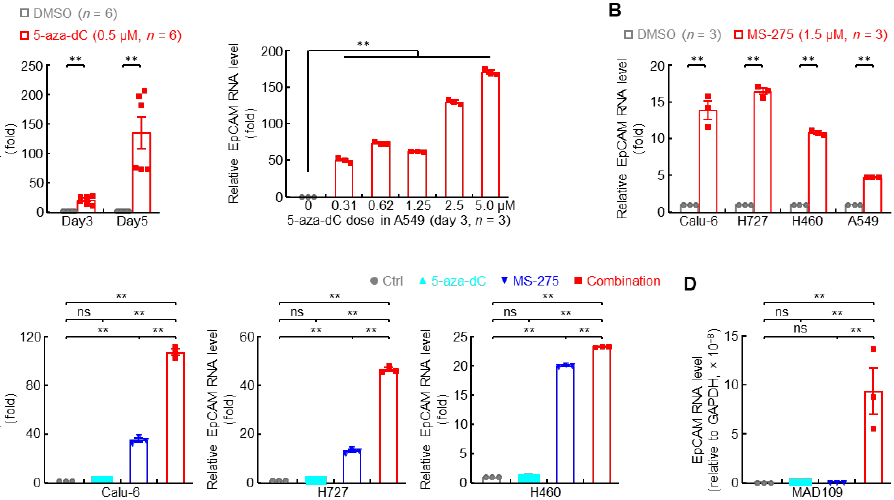
Figure 6. Epigenetic drugs restore EpCAM expression in highly metastatic lung cancer cells. ( A ) qPCR data showing recovered EpCAM RNA expression by DNMT inhibitor (5-aza-dC) in human highly metastatic lung cancer cell A549. ( B ) qPCR data showing restored EpCAM RNA expression by HDAC1 inhibitor (MS-275, 72 hr) in human highly metastatic lung cancer cells. ( C , D ) qPCR data showing synergistic induction of EpCAM RNA expression by DNMT inhibitor (5-aza-dC) and HDAC1 inhibitor (MS-275) in human ( C ) and murine ( D ) highly metastatic lung cancer cells. Data are representative of three independent experiments with similar results. Student’s t test (two-tailed, unpaired) was performed. Data represent means ± SEM. ** p < 0.01; ns, not statistically different.